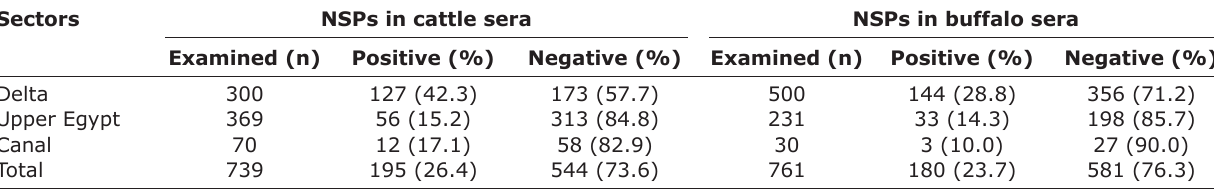
Table-1: Detection of antibodies against NSPs of FMDV (DIVA test) in cattle and Buffaloes sera using 3ABC ELISA.